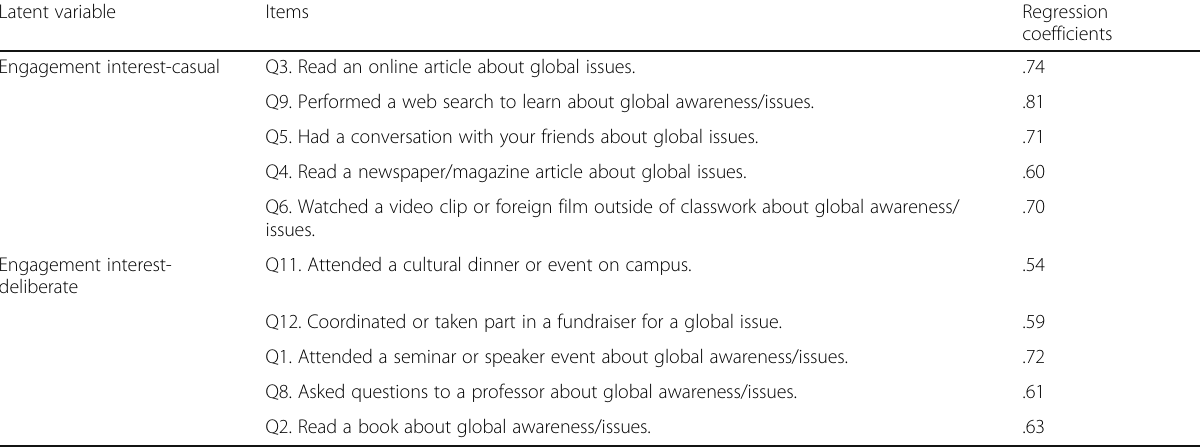
Table 3 CFA standardized regression coefficients for the engagement interest items ( p < 0.001 for all items) Latent variable